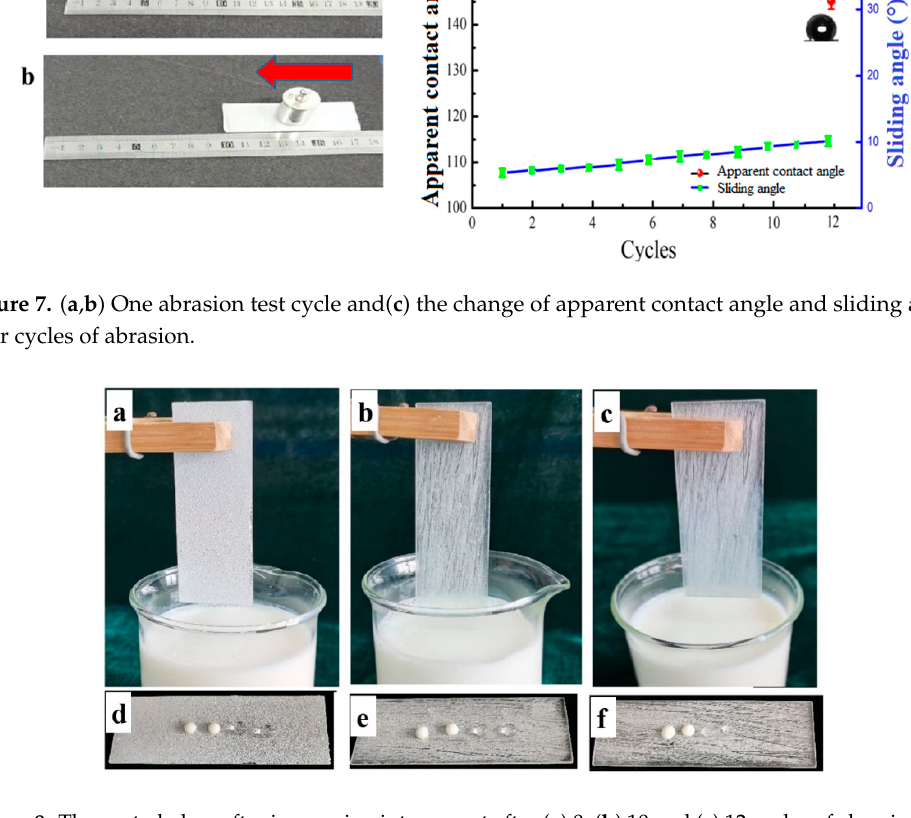
Figure 8. The coated glass after immersion into yogurt after ( a ) 0; ( b ) 10 and ( c ) 12 cycles of abrasion test; Photographs of yogurt and water droplets on a coated glass surface after ( d ) 0; ( e ) 10 and ( f ) 12 cycles of abrasion test.